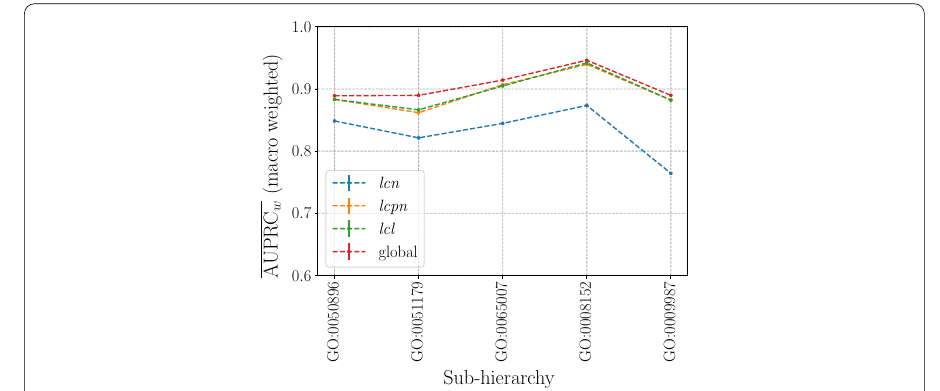
Fig. 8 Prediction performance of the proposed approach measured with the average area under the PR curve, i.e., AUPRC w . The performance is measured independently per sub-hierarchy